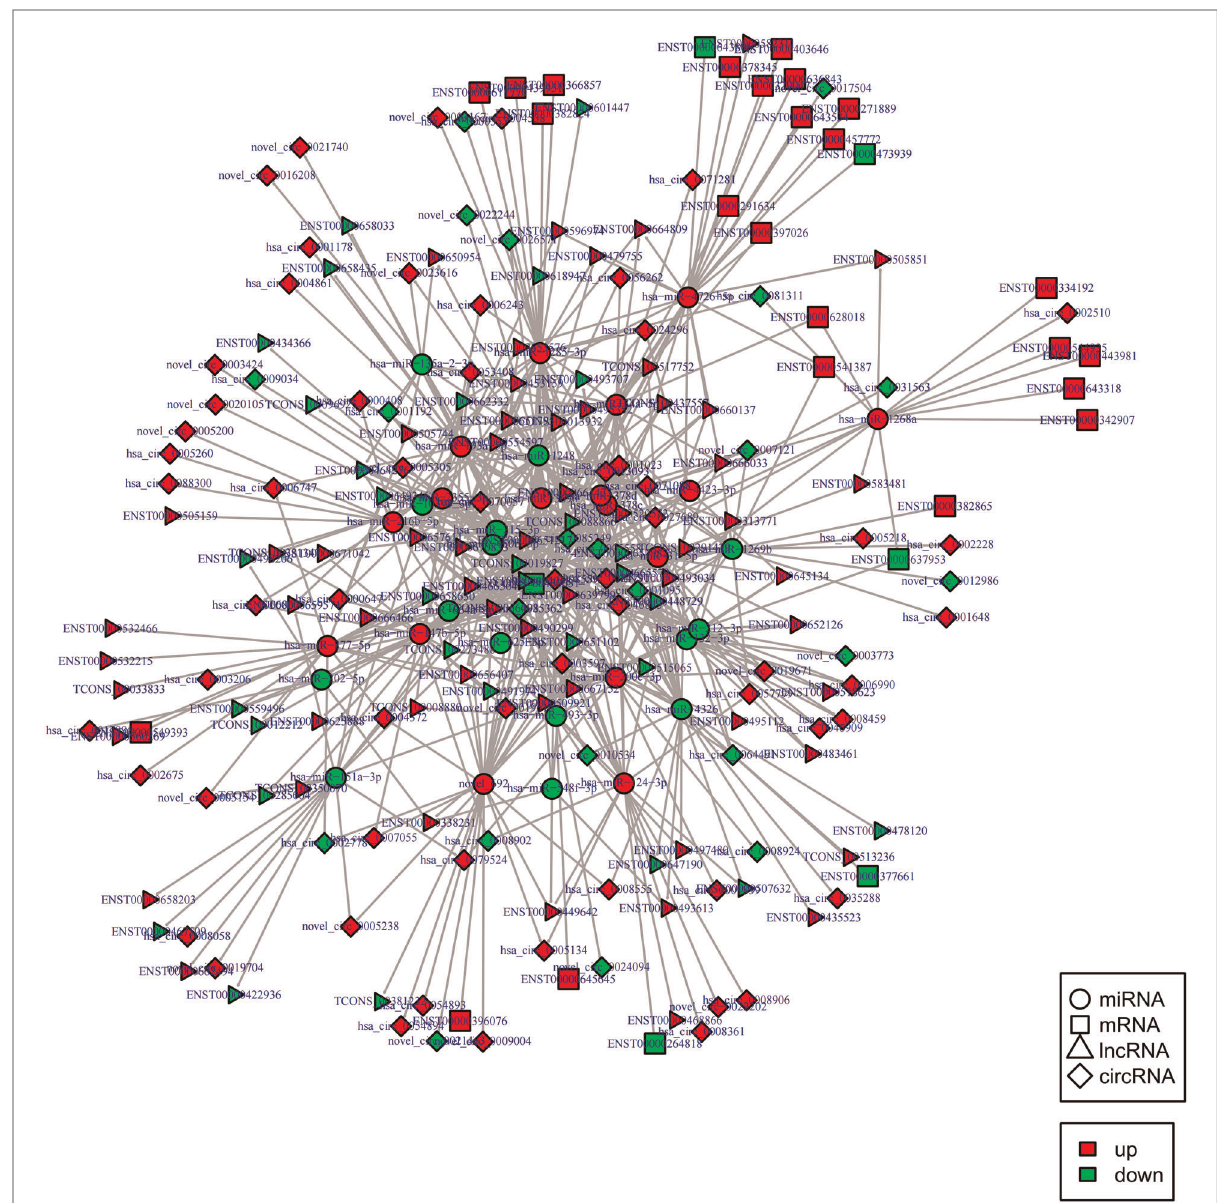
FIGURE 7 CircRNA-lncRNA co-regulated ceRNA network. Circle: miRNA, square: mRNAs, triangle: lncRNA, diamond: circRNA. Red: up-regulation, green: